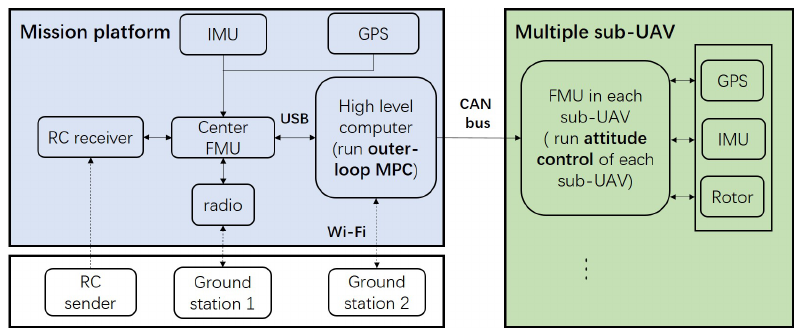
Figure 7. Hardware architecture of the assembly